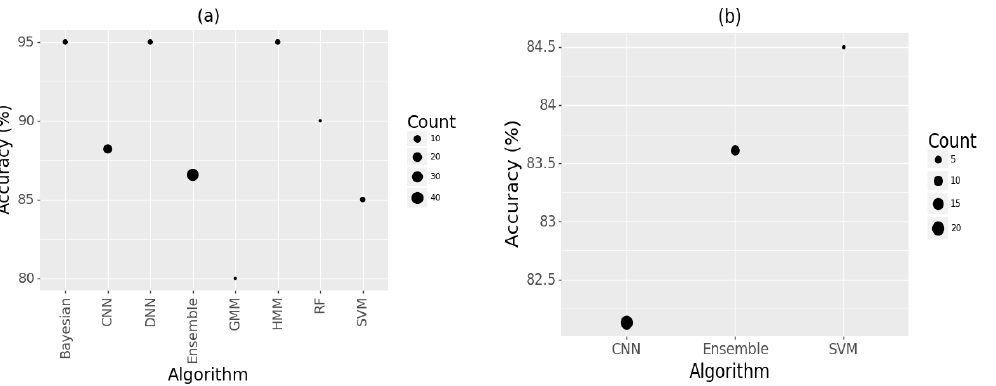
Figure 13. Classification algorithms used for ( a ) bioacoustics and ( b ) general acoustics